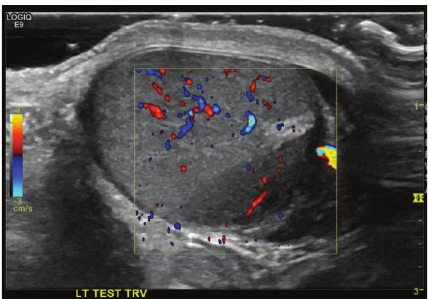
Figure 2: Testicular ultrasound showing hypoechoic lesion in left